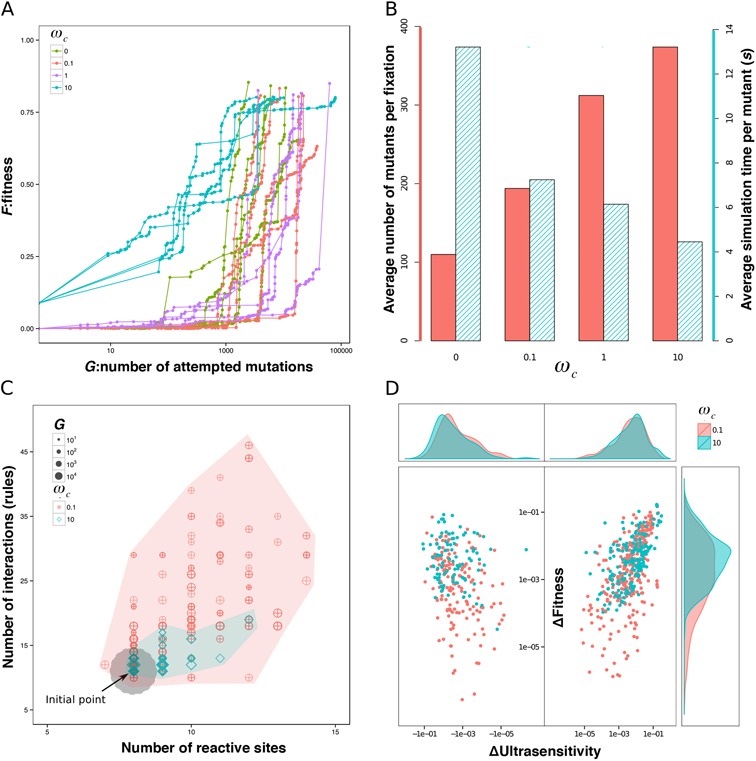
Results from sample evolutionary simulations. (A) The fitness score plotted against the total number of mutations sampled. Each curve depicts the results of a single evolutionary simulation, which is a biased random walk over the network space (Equation [5] in ‘Materials and Methods’ section). Each dot on each curve represents an accepted mutation (lines are to guide the eye). Distances along the x-axis between two dots indicate the number of mutations sampled between two accepted mutations. In all simulations, fitness increases with the number of mutations accepted, but in two simulations (one with \documentclass[12pt]{minimal}
\usepackage{amsmath}
\usepackage{wasysym}
\usepackage{amsfonts}
\usepackage{amssymb}
\usepackage{amsbsy}
\usepackage{upgreek}
\usepackage{mathrsfs}
\setlength{\oddsidemargin}{-69pt}
\begin{document}
}{}$\omega _c = 0$\end{document} and one with \documentclass[12pt]{minimal}
\usepackage{amsmath}
\usepackage{wasysym}
\usepackage{amsfonts}
\usepackage{amssymb}
\usepackage{amsbsy}
\usepackage{upgreek}
\usepackage{mathrsfs}
\setlength{\oddsidemargin}{-69pt}
\begin{document}
}{}$\omega _c = 0.1$\end{document}) fitness fails to reach the target level of 0.8 before the maximal simulation time of 120 h is reached. (B) The average number of mutants sampled before a mutation is accepted increases with \documentclass[12pt]{minimal}
\usepackage{amsmath}
\usepackage{wasysym}
\usepackage{amsfonts}
\usepackage{amssymb}
\usepackage{amsbsy}
\usepackage{upgreek}
\usepackage{mathrsfs}
\setlength{\oddsidemargin}{-69pt}
\begin{document}
}{}$\omega _c$\end{document}; the average time for evaluating the fitness of each mutant in simulations decreases with \documentclass[12pt]{minimal}
\usepackage{amsmath}
\usepackage{wasysym}
\usepackage{amsfonts}
\usepackage{amssymb}
\usepackage{amsbsy}
\usepackage{upgreek}
\usepackage{mathrsfs}
\setlength{\oddsidemargin}{-69pt}
\begin{document}
}{}$\omega _c$\end{document}. A higher weighting of complexity score (\documentclass[12pt]{minimal}
\usepackage{amsmath}
\usepackage{wasysym}
\usepackage{amsfonts}
\usepackage{amssymb}
\usepackage{amsbsy}
\usepackage{upgreek}
\usepackage{mathrsfs}
\setlength{\oddsidemargin}{-69pt}
\begin{document}
}{}$\omega _c$\end{document}) in the total score gives a higher penalty to mutations that generate complexity in the network structure. (C) The evolutionary space showing the numbers of reactive sites and of interactions for all simulations with \documentclass[12pt]{minimal}
\usepackage{amsmath}
\usepackage{wasysym}
\usepackage{amsfonts}
\usepackage{amssymb}
\usepackage{amsbsy}
\usepackage{upgreek}
\usepackage{mathrsfs}
\setlength{\oddsidemargin}{-69pt}
\begin{document}
}{}$\omega _c = 0.1{\rm and}10$\end{document}. Each data point represents an accepted mutant network from different stages of the simulation, with the shape and color indicating the \documentclass[12pt]{minimal}
\usepackage{amsmath}
\usepackage{wasysym}
\usepackage{amsfonts}
\usepackage{amssymb}
\usepackage{amsbsy}
\usepackage{upgreek}
\usepackage{mathrsfs}
\setlength{\oddsidemargin}{-69pt}
\begin{document}
}{}$\omega _c$\end{document} of the simulation and the size indicating the generation number (i.e. number of mutations). Note that many of the data points from the simulations with \documentclass[12pt]{minimal}
\usepackage{amsmath}
\usepackage{wasysym}
\usepackage{amsfonts}
\usepackage{amssymb}
\usepackage{amsbsy}
\usepackage{upgreek}
\usepackage{mathrsfs}
\setlength{\oddsidemargin}{-69pt}
\begin{document}
}{}$\omega _c = 10$\end{document} are overlapping. The initial network is at the center of the gray area. (D) The distributions of mutational effects on fitness and ultrasensitivity from accepted mutations during all simulations with \documentclass[12pt]{minimal}
\usepackage{amsmath}
\usepackage{wasysym}
\usepackage{amsfonts}
\usepackage{amssymb}
\usepackage{amsbsy}
\usepackage{upgreek}
\usepackage{mathrsfs}
\setlength{\oddsidemargin}{-69pt}
\begin{document}
}{}$\omega _c = 0.1{\rm and}10$\end{document} (as indicated in red and green respectively). Sub-graphs at the top and right are density estimates for the ultrasensitivity changes \documentclass[12pt]{minimal}
\usepackage{amsmath}
\usepackage{wasysym}
\usepackage{amsfonts}
\usepackage{amssymb}
\usepackage{amsbsy}
\usepackage{upgreek}
\usepackage{mathrsfs}
\setlength{\oddsidemargin}{-69pt}
\begin{document}
}{}$\Delta S_{ult}$\end{document} and fitness changes \documentclass[12pt]{minimal}
\usepackage{amsmath}
\usepackage{wasysym}
\usepackage{amsfonts}
\usepackage{amssymb}
\usepackage{amsbsy}
\usepackage{upgreek}
\usepackage{mathrsfs}
\setlength{\oddsidemargin}{-69pt}
\begin{document}
}{}$\Delta F$\end{document} of all fixation events.